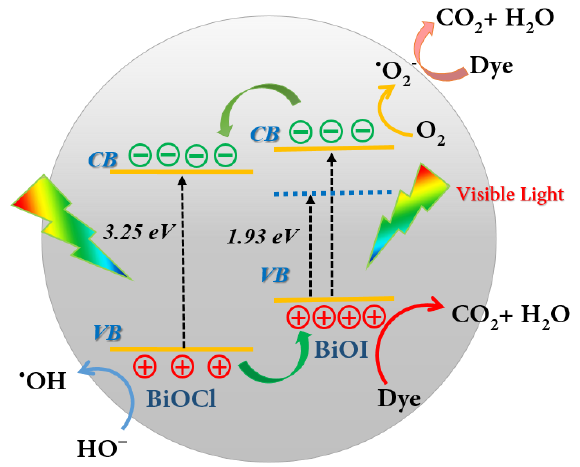
Figure 13. Proposed mechanistic diagram of the photocatalytic process for the BiOI/BiOCl photocatalyst under visible light irradiation.